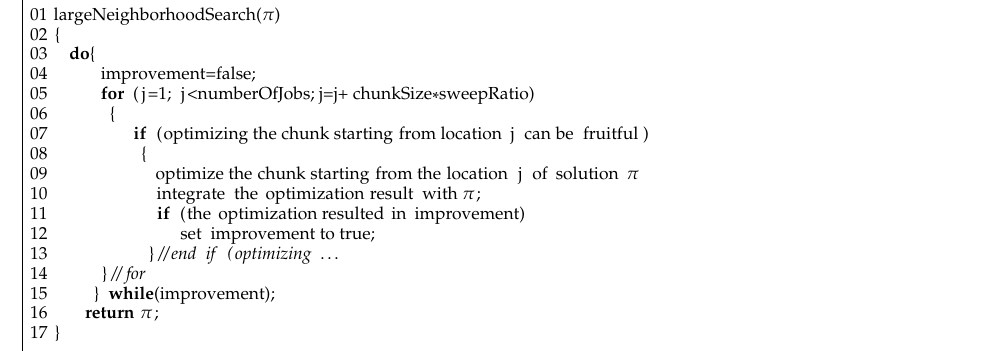
Figure 5. The c-type pseudocode of